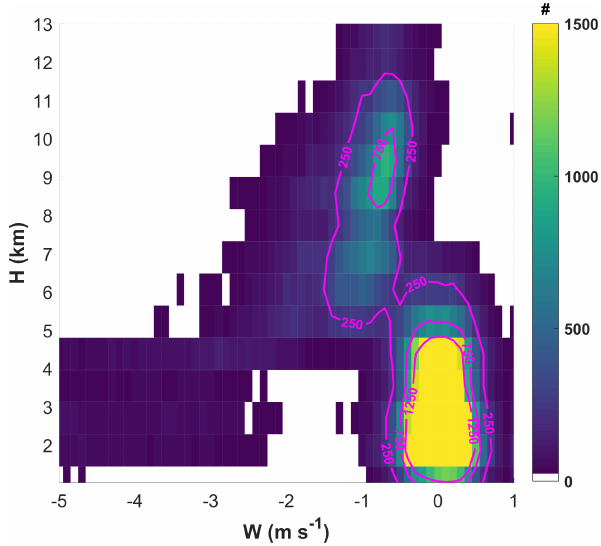
Figure 11. Contoured frequency by altitude diagram of the vertical velocity W obtained by the RWP collected during 54d of measure- ments between 16 October and 8 December 2020. The vertical res- olution is 840m, while the W resolution is 0.1ms − 1 . The contours show the number of data points (magenta